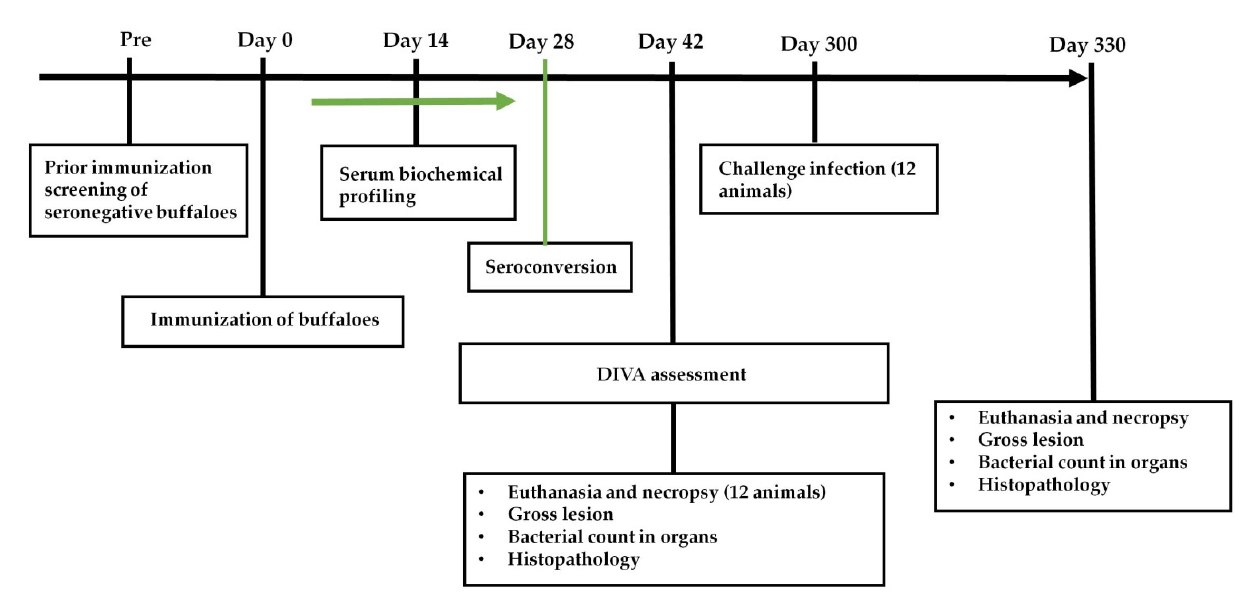
Figure 1. Immunization, sample collection and investigation